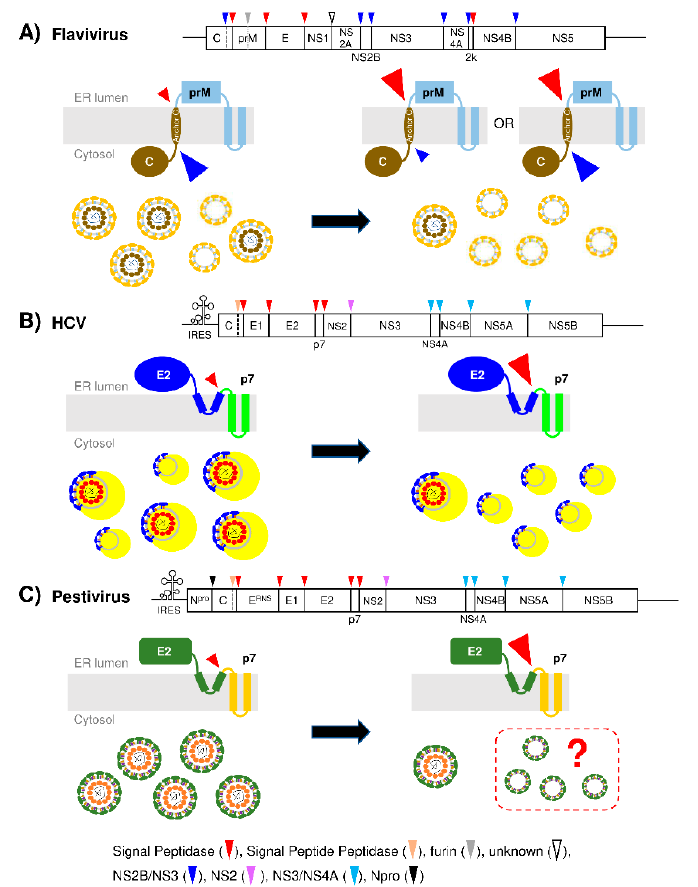
Figure 1. Flaviviridae virus genome organization and delayed signal peptidase cleavage sites involved in virus assembly. ( A ) The top panel shows the flavivirus genome organization marked with host-